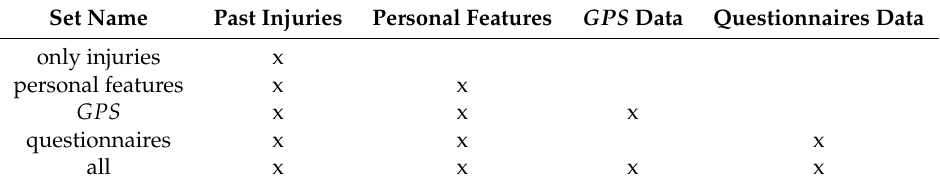
Table 3. Attributes